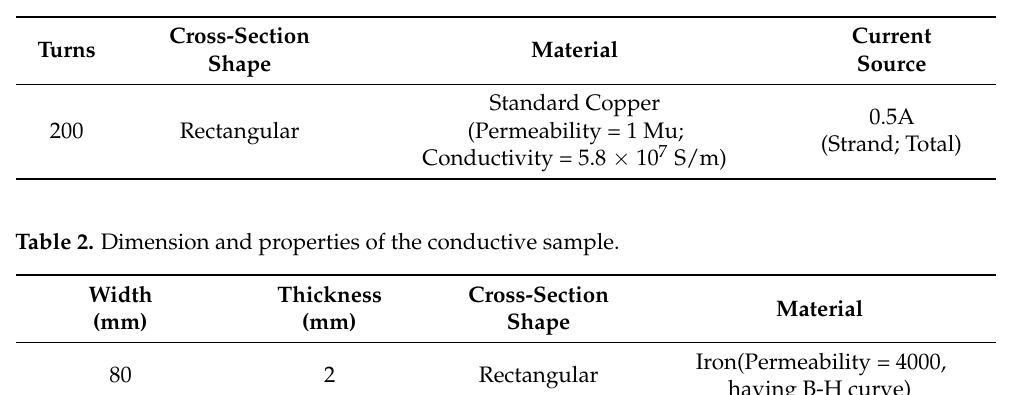
Figure 2. Simulation model for excitation device. Table 1. Properties of the excitation coil. Table 1. Properties of the excitation coil.